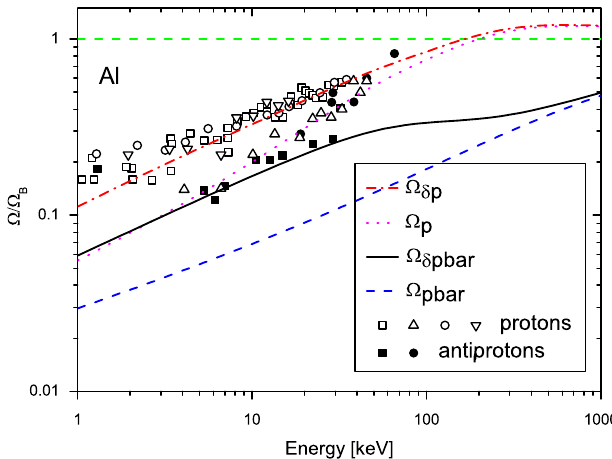
FIG. 4. Angular spread half-width due to multiple scattering (vertical axis) versus reciprocal incident energy in inverse keV (horizontal axis) for a variety of positive ions passing through carbon foils, reproduced from [24]. Linear least-squares fits are indicated. The bottom curve corresponds to protons ( H þ ), and was used to estimate a value of (cid:10) (cid:9) (cid:3) 0 : 11